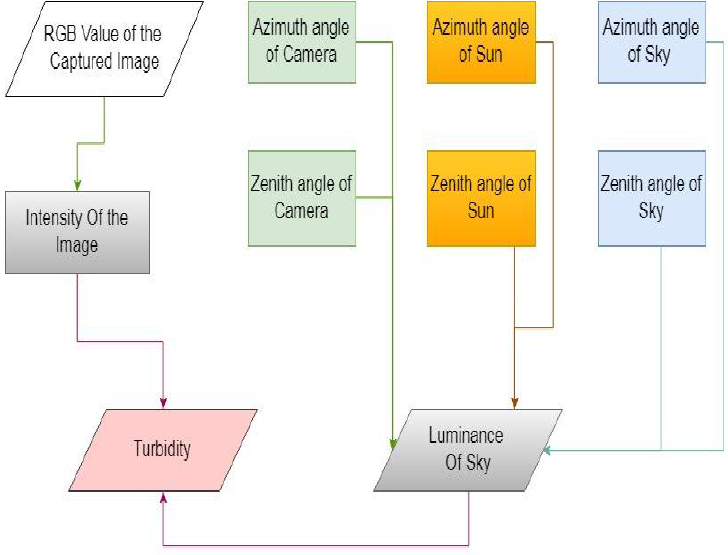
F IGURE 3: T URBIDITY E